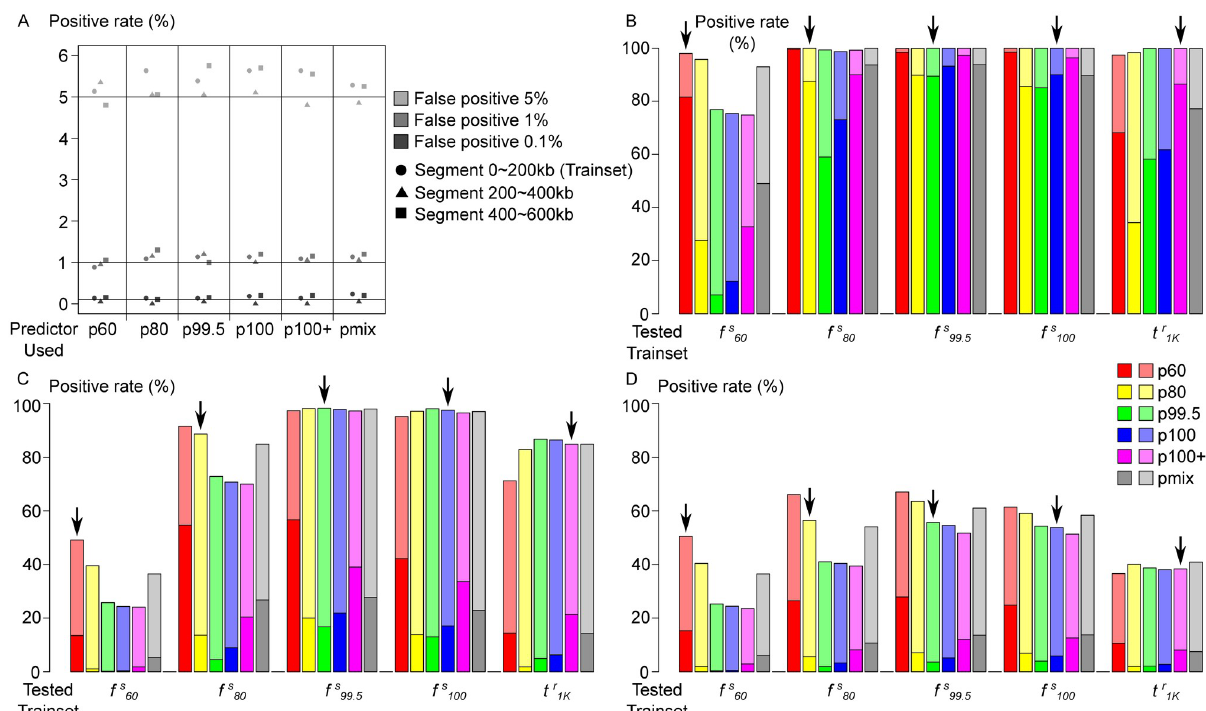
Fig 5. Full-locus simulation: Cross-testing EvolBoosting predictors in simulated panmictic populations. A: False positive of neutral data, where only the segment 0–200kb (circles) is used as training sets. Similarity among the three segments indicate absence of over-fitting. B-D: The proportion of samples detected as soft (lighter color) or hard (darker color) selective sweeps, using each other’s training sets for testing. B: Cross-testing using hard sweep samples of different stages, using the region within 100kb from selection site. C: Cross-testing using soft sweep samples of different stages, using the region within 100kb from selection site. D: Cross-testing using hard sweep samples of different stages, but using the region 100–300kb away from selection site. The down-arrow indicates where the tested dataset matches the stage of predictor.